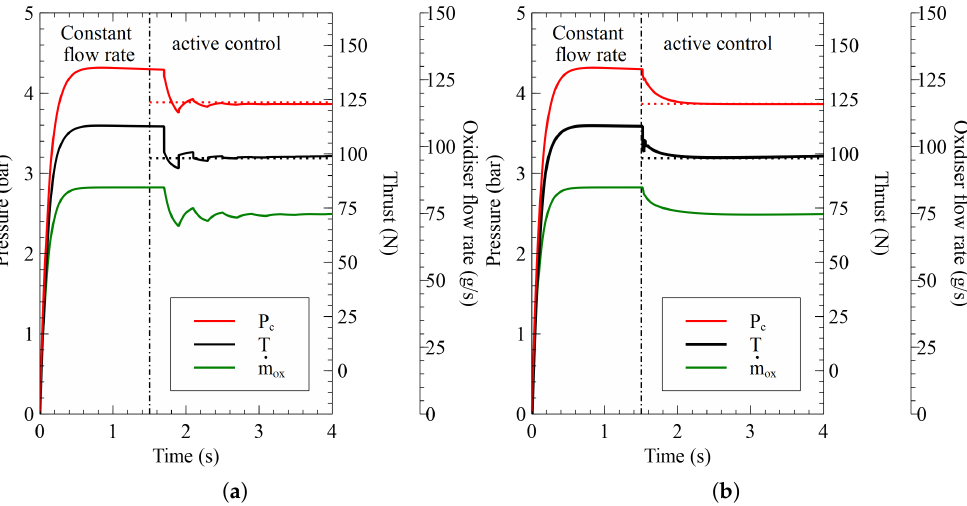
Figure 13. Simulation results of closed-loop thrust control algorithm where T des = 98N (10kgf), and